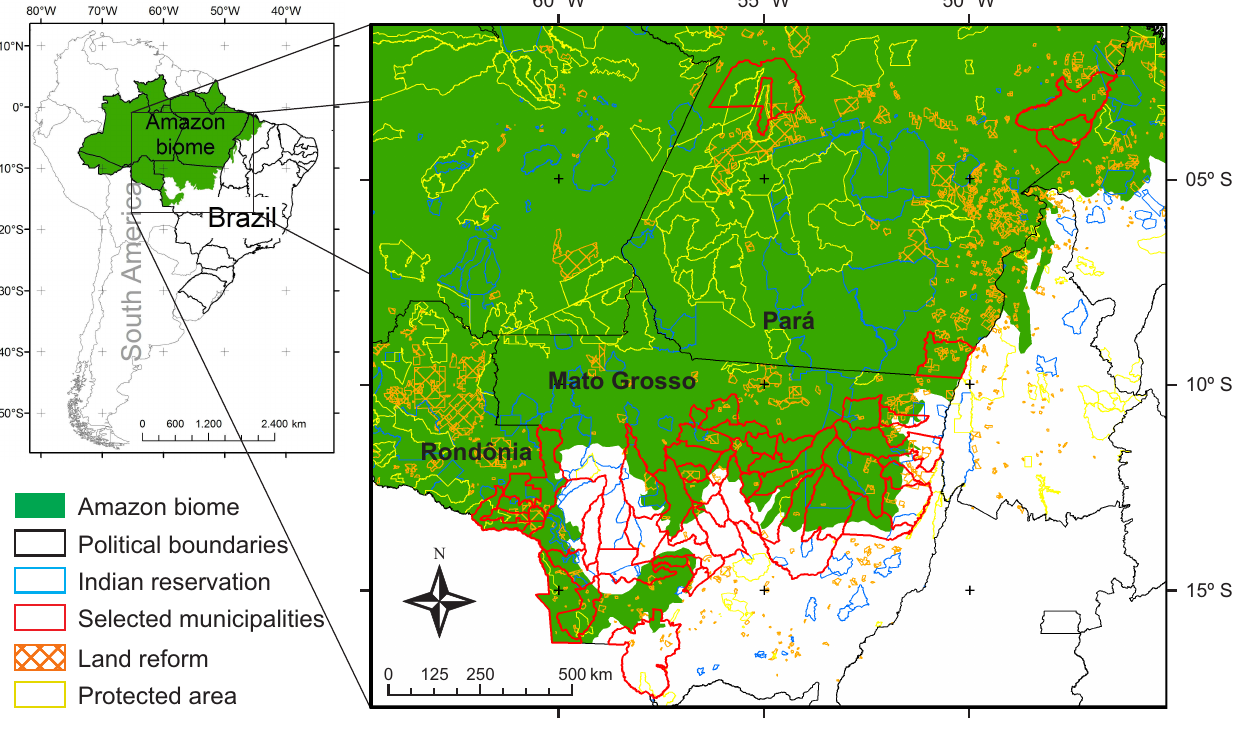
Figure 2. Example of the fusion of four PRODES polygons. Without fusion (a) , two polygons would not be monitored because they measure less than 25 ha. After fusion (b) a single polygon was formed with an area greater than 25